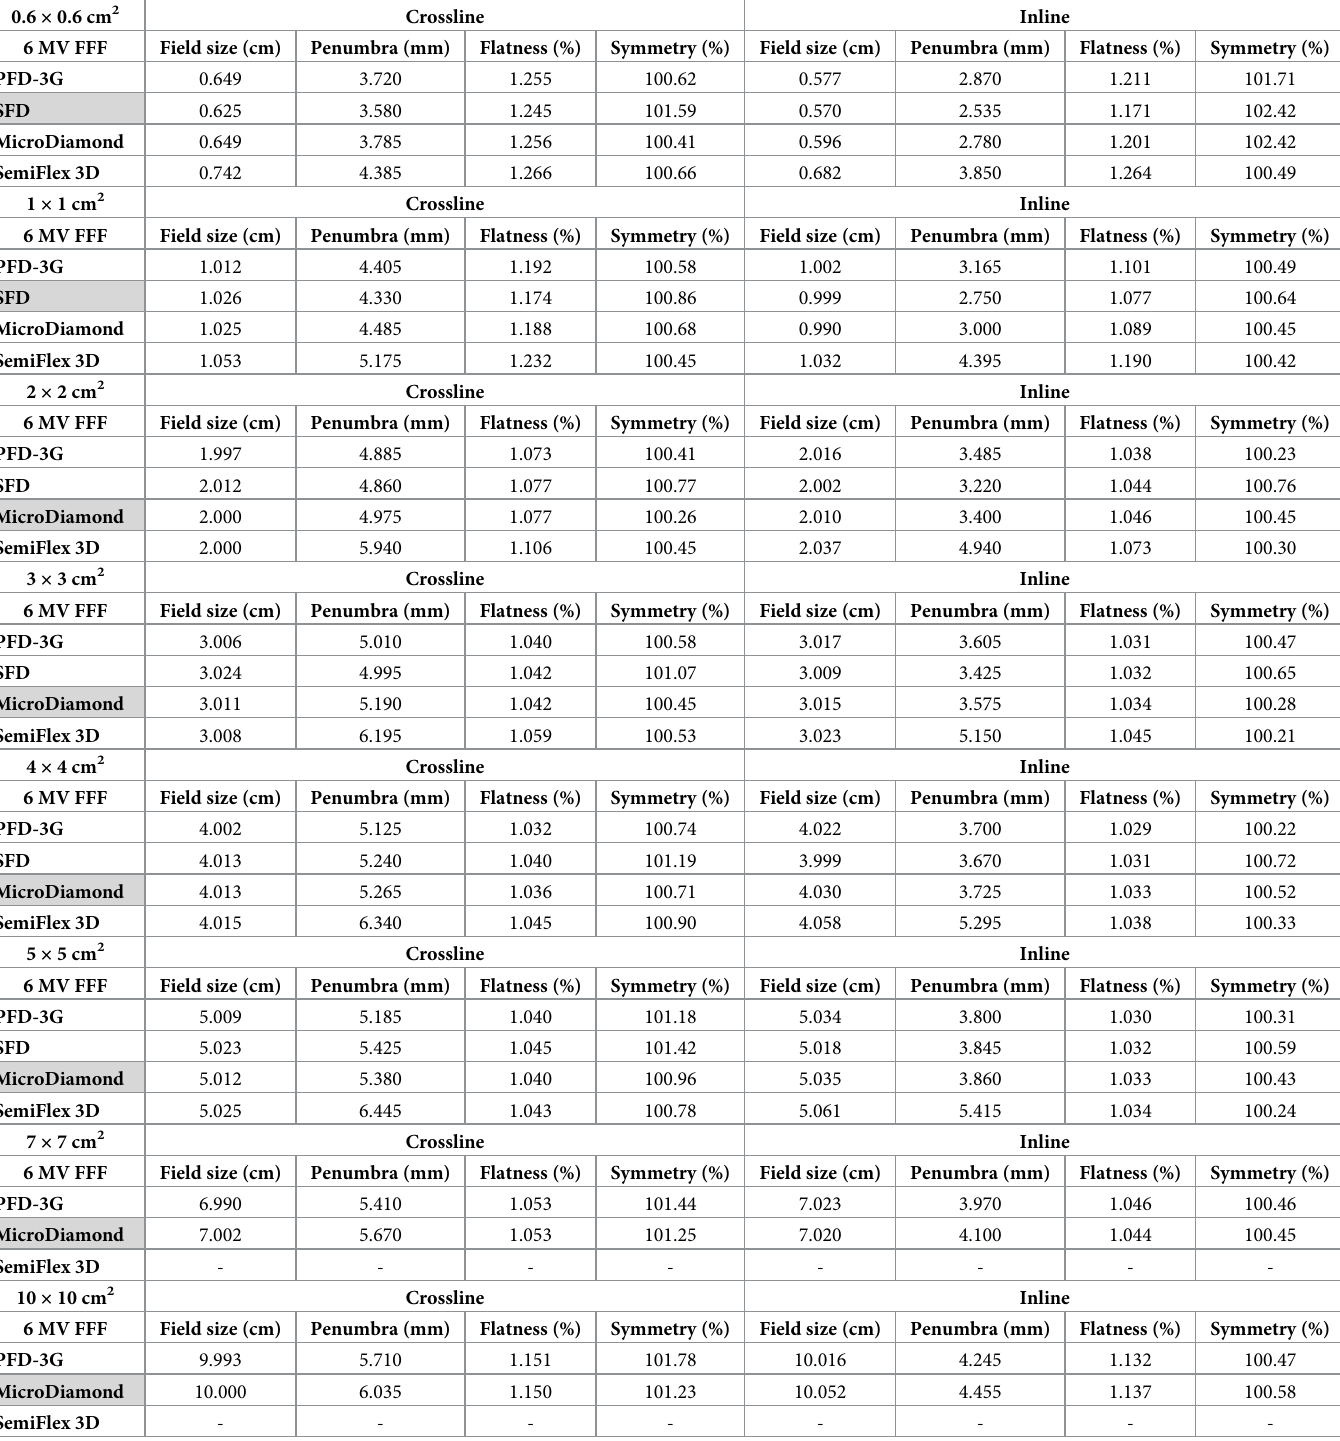
Table 7. Results of the crossline and inline profile parameters for different detectors at a 100-mm depth depending on the field size for 6 MV FFF